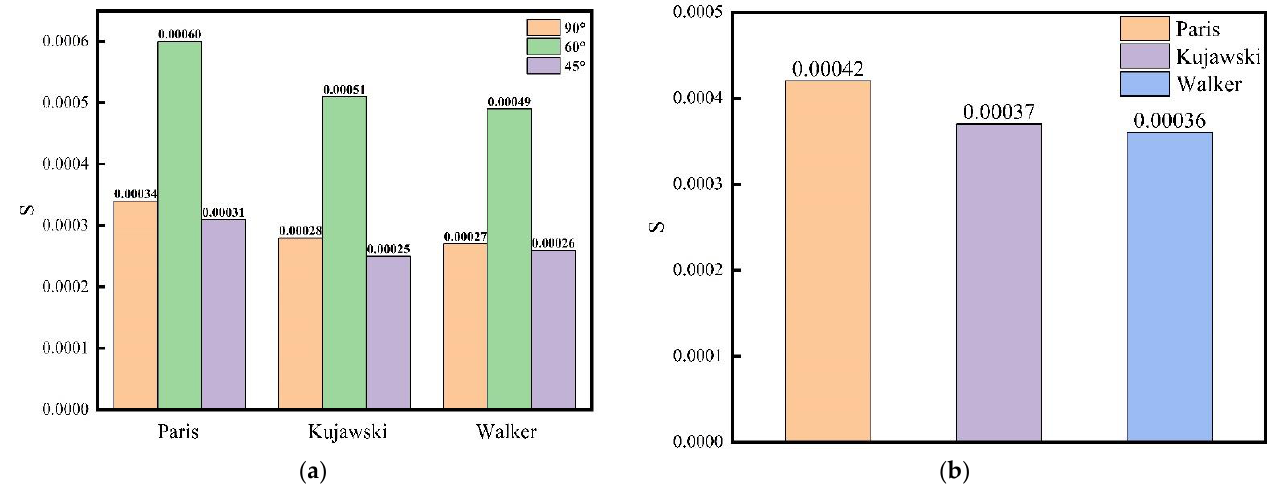
Figure 17. ( a ) Discrete error diagram of Paris, Kujawski and Walker models ( b )Total discrete error histogram of Paris, Kujawski and Walker models.